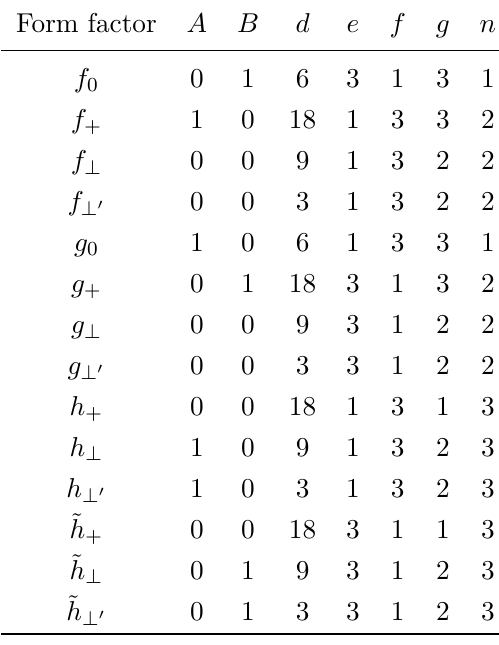
Table 2 . Coefficients involved in the outer